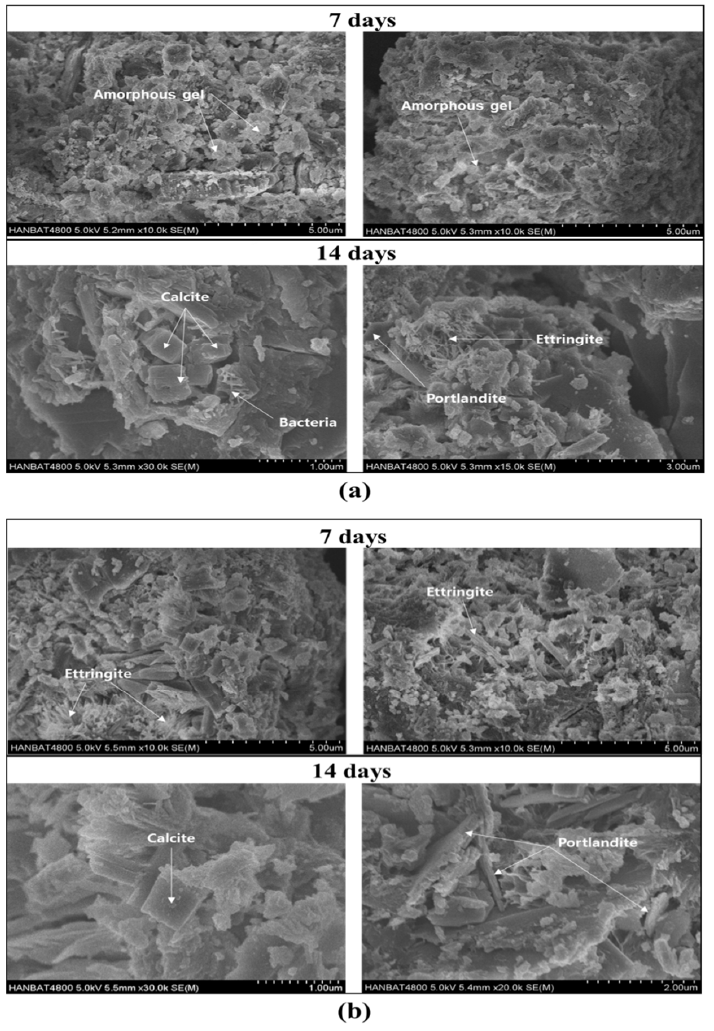
Figure 5. SEM images of the A0 ( a ) and A3 ( b ) paste specimens on the 7th and 14th days.